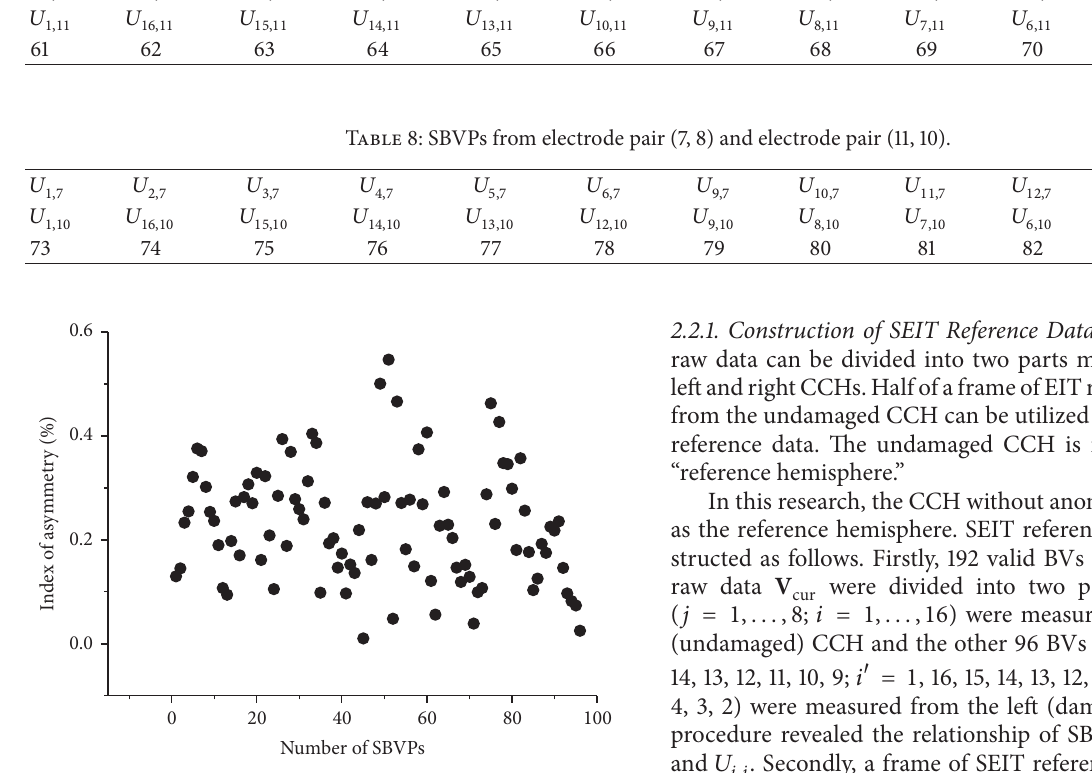
Figure 5: Index of asymmetry (IA) of the 2D FEM of human head.